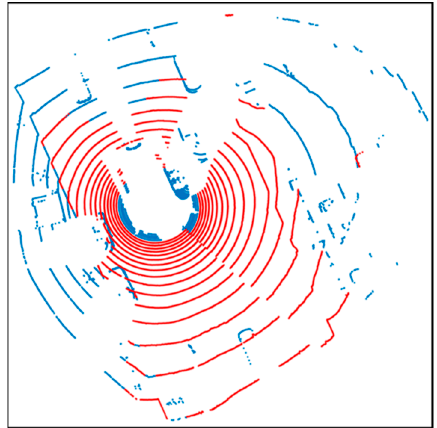
Figure 6. Road surface extraction using height filter.